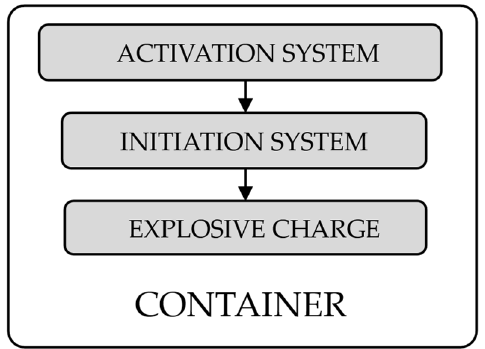
Figure 1. Basic elements of an IED.